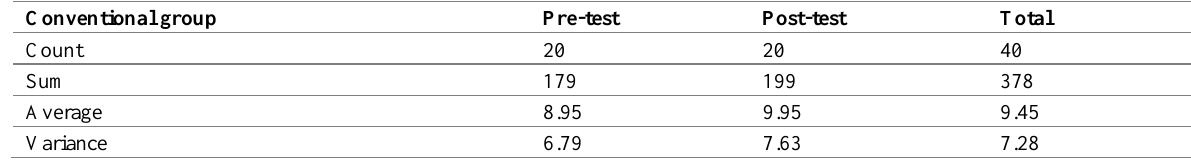
Table 1 above encapsulates the sample size, average scores and variance between the pre-test and post-test of the control group. The count is indicative of the sample size; therefore 20 Grade 11 Life Sciences students’ scripts were randomly selected for the control group and 20 for the improvised